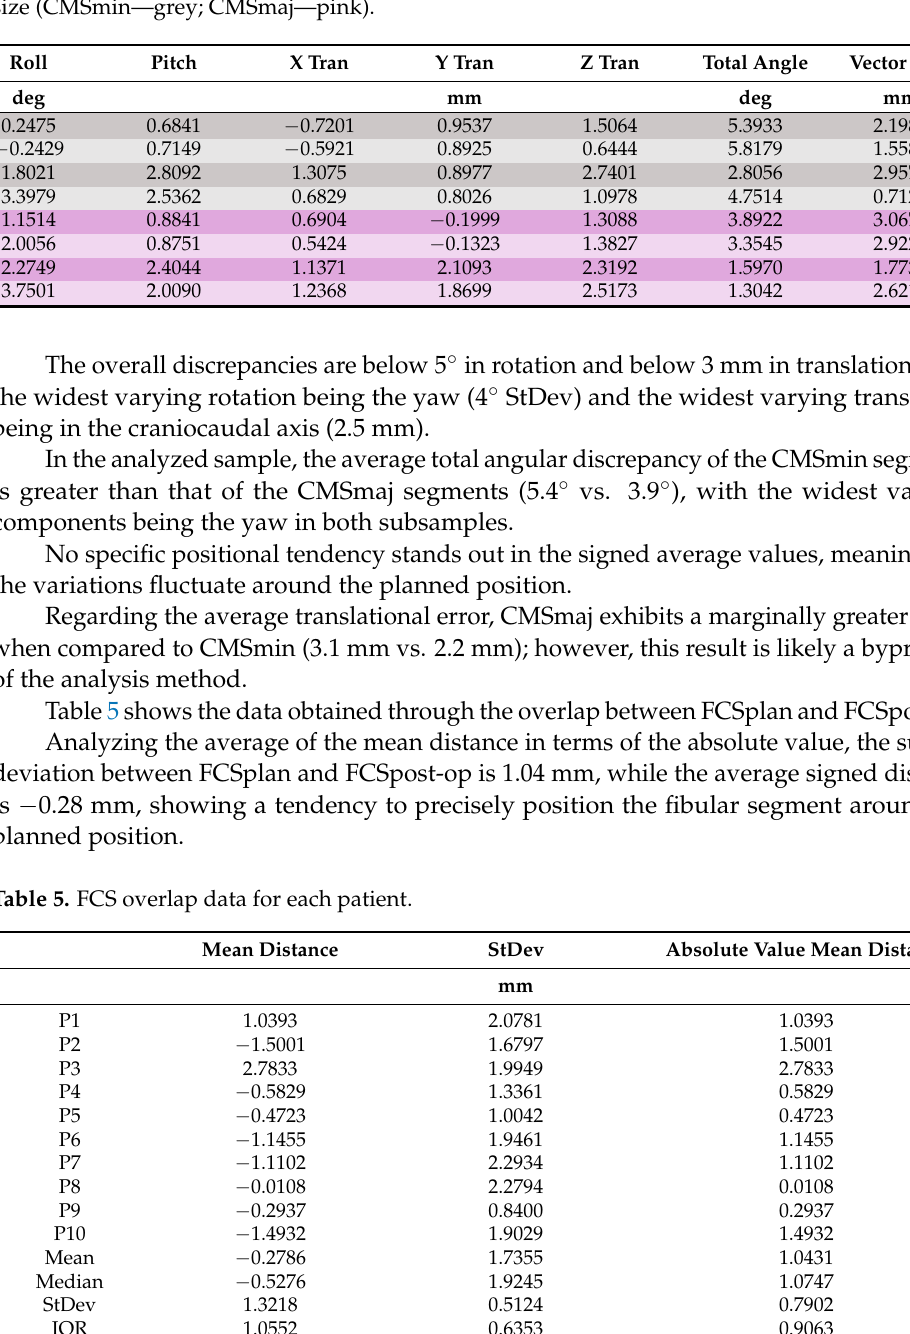
Table 4. Descriptive statistics regarding the roto-translation of the segments divided by CMS segment size (CMSmin—grey; CMSmaj—pink).